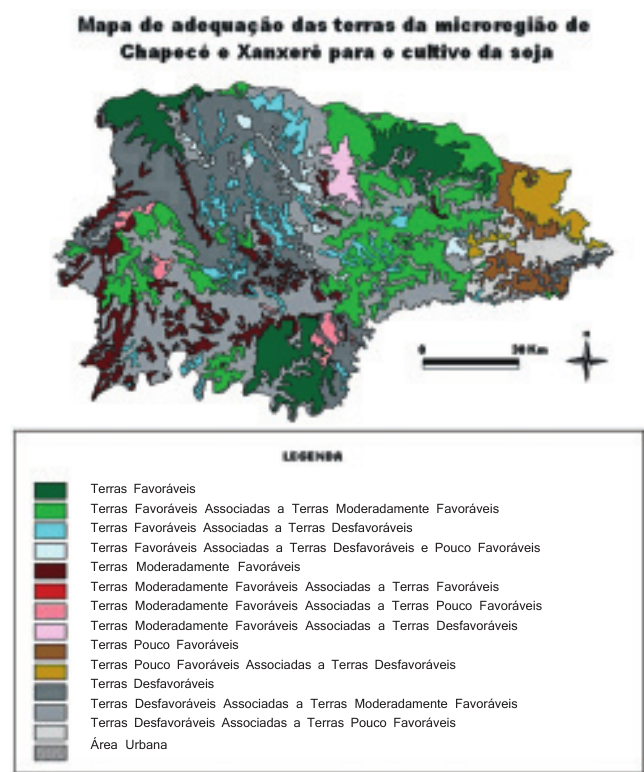
Figura 9. Classes de adequação das terras para o cultivo da